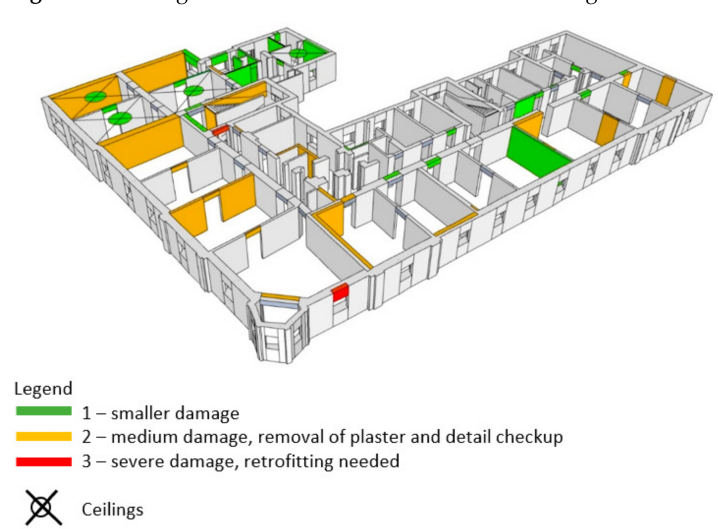
Figure 11. Damage scheme for the 2nd floor of the building.